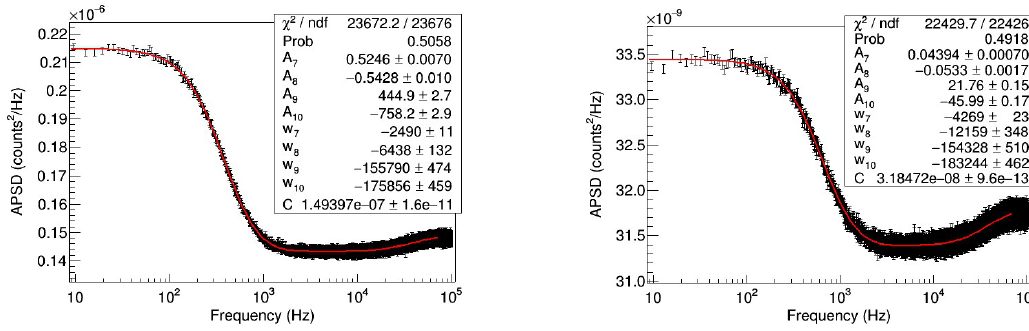
Figure 2. APSD for the Cases of 286.8 and 578.6 ppm of Natural